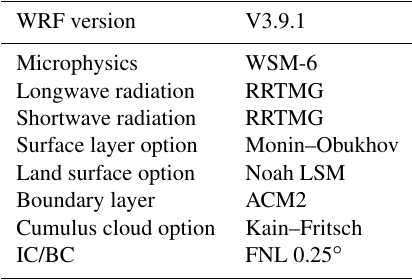
Table 2. WRF physics